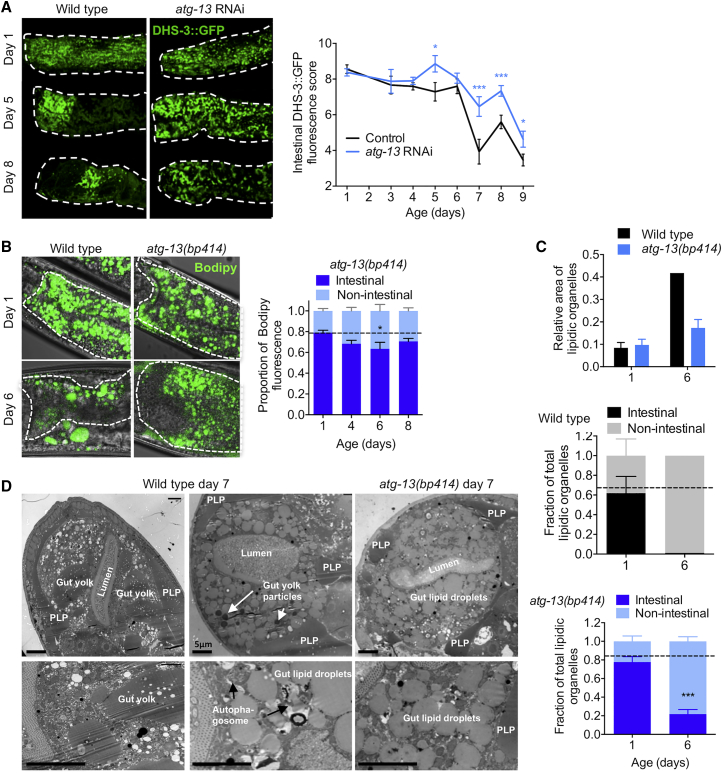
Inhibition of atg-13 Reduces Age-Associated Lipid Redistribution(A) Adult-limited atg-13 RNAi delays the age-associated decrease in DHS-3::GFP-labeled intestinal lipid droplets. Images showing labeling of intestinal lipid droplets using DHS-3::GFP in control and atg-13 RNAi animals (left). Quantification of DHS-3::GFP-labeled intestinal lipid droplets (right).(B) Age-associated lipid redistribution is inhibited by atg-13(bp414). Bodipy staining of neutral lipids in control and atg-13 RNAi animals reveals preservation of Bodipy-labeled intestinal lipid content (cf. Figure 3G).(C) Quantification of lipidic organelles using TEM. Age-related increase in lipidic area is suppressed by atg-13(bp414) (top). Relative intestinal lipidic organelle content is preserved during aging in atg-13(bp414) compared to wild-type (middle and bottom).(D) TEM images at 3,000× (top) and 10,000× (bottom) of wild-type (left and center) and atg-13(bp414) (right) worm sections on day 7 of adulthood. atg-13(bp414) worms have reduced PLPs and increased intestinal lipid droplets compared to wild-type.∗p < 0.05, ∗∗∗p < 0.001. See also Table S1.